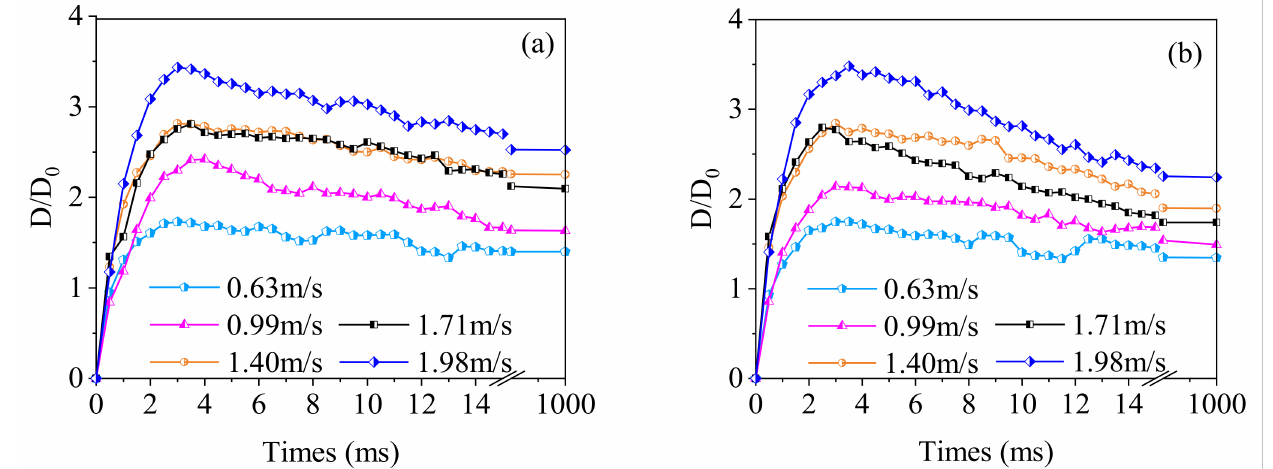
Figure 4. Relation curve between spreading factor with time. ( a ) Adaxial side; ( b ) abaxial side.